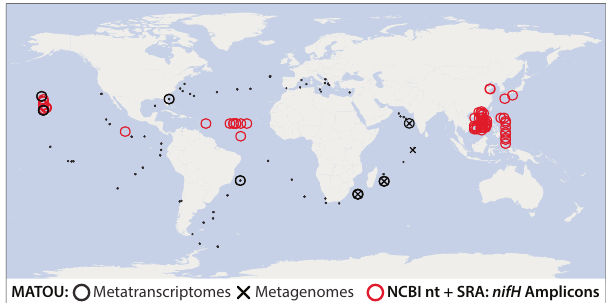
Fig. 3 Global map of environmental sequences that share 100% nucleotide identity with an E. pelagica nifH phylotype. Datasets screened include the Marine Atlas of Tara Oceans Unigenes (MATOU) and the representation of unigene MATOU-v1_93255274 in Tara Oceans metagenomes and metatranscriptomes, as well as nifH amplicons published in NCBI ’ s non-redundant nucleotide (nt) and Sequence Read Archive (SRA) databases. Black dots indicate the location of Tara Oceans stations analyzed in MATOU. Source data are provided in the Source Data fi